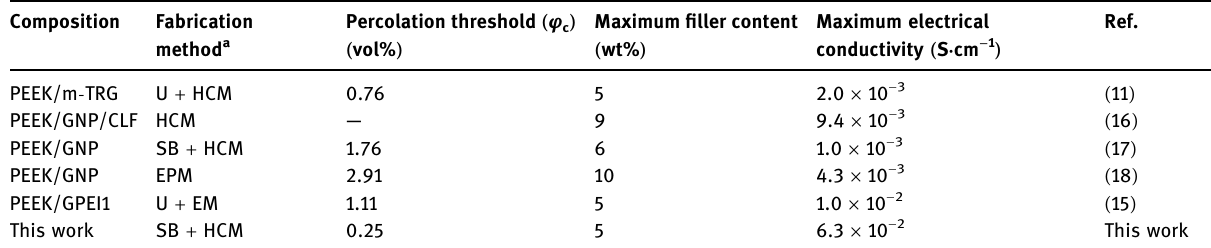
Table 2: A comparison of fabrication method, electrical percolation threshold, and maximum electrical conductivity of PEEK/Gr